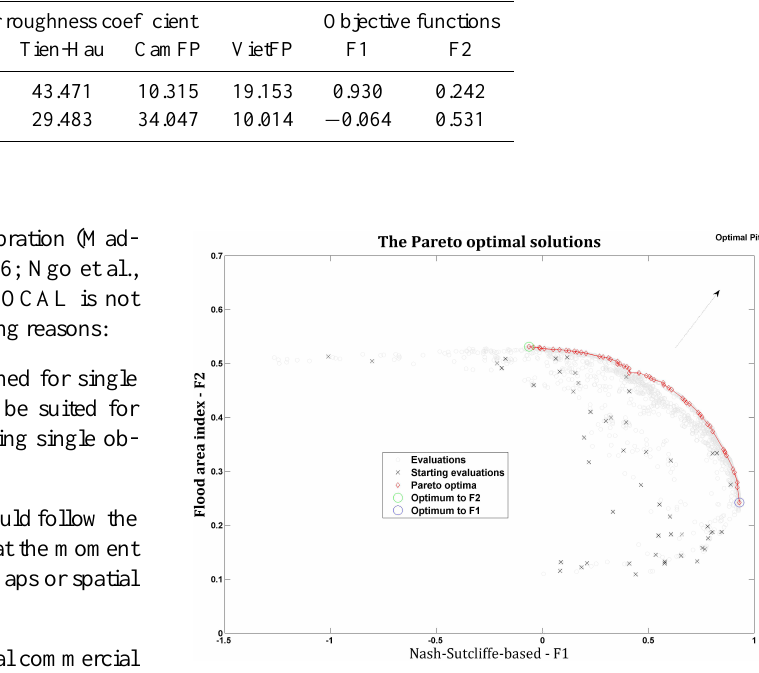
Fig. 8. Pareto-optimal solutions of the final population maximizing the objective